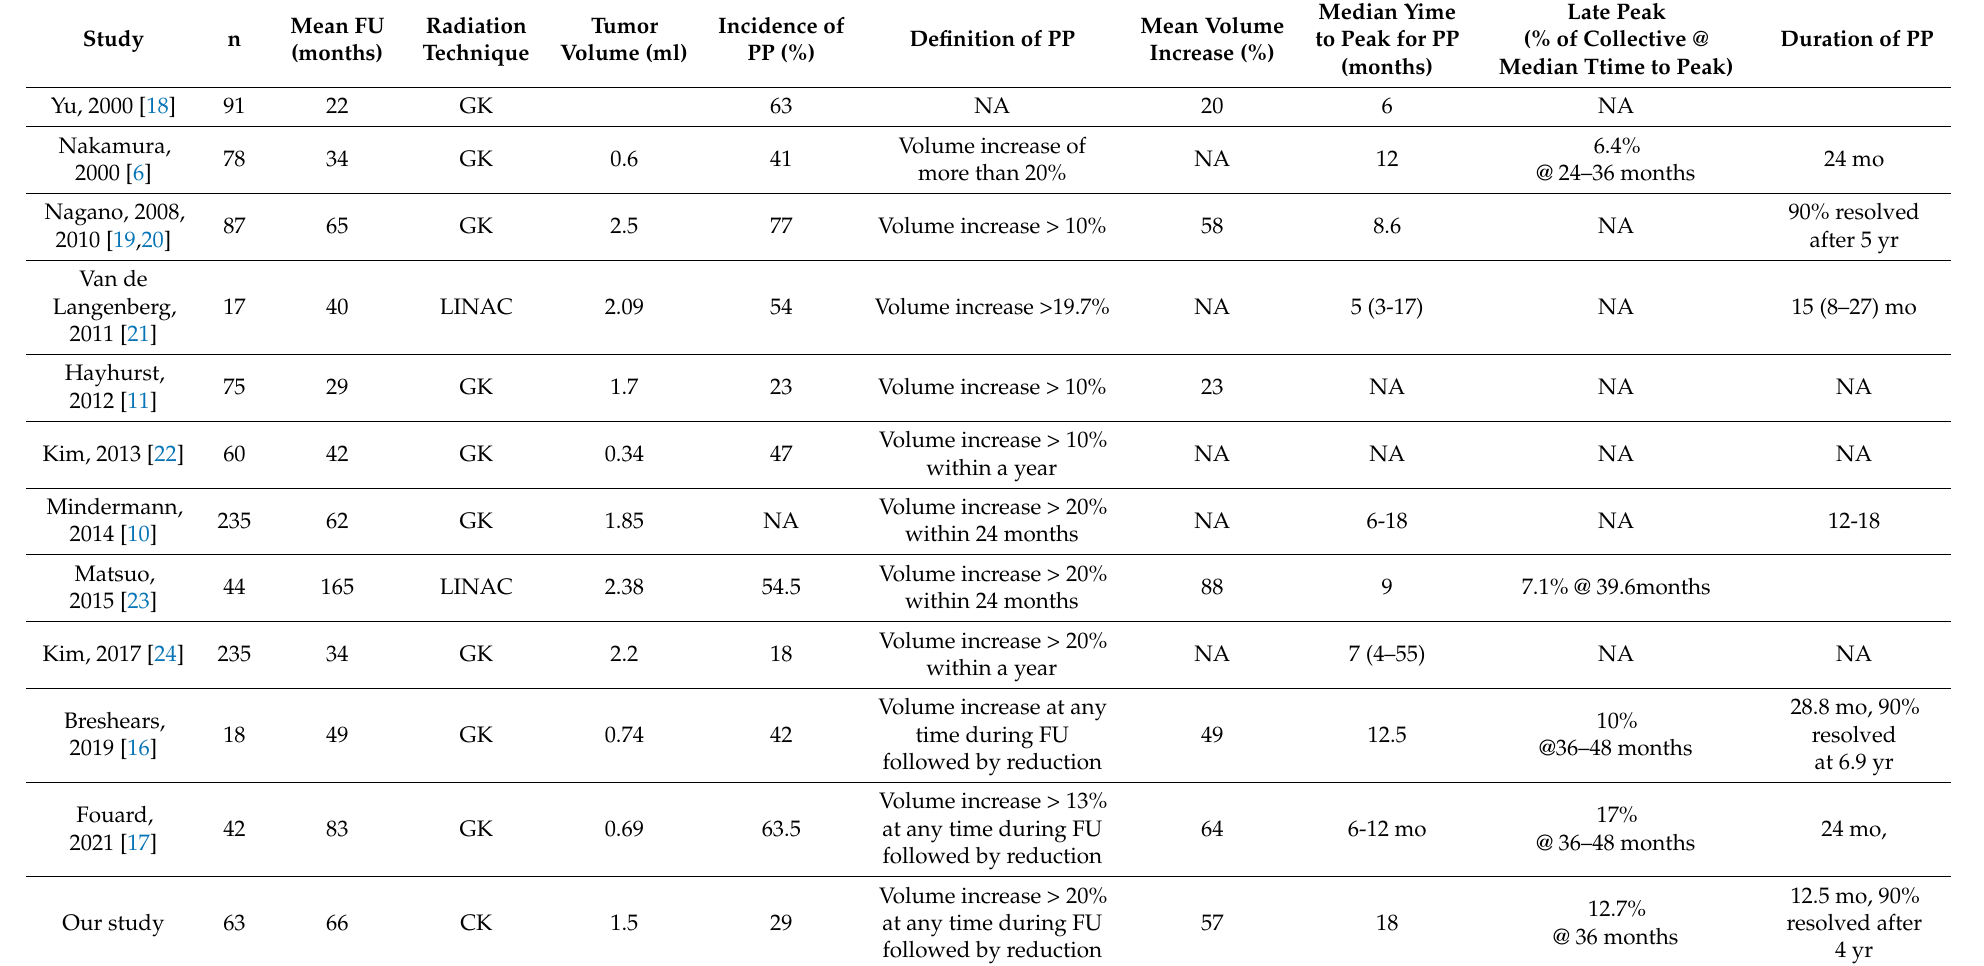
Table 4. Summary of pseudoprogression after single fraction SRS of vs. evaluated by volumetric analysis in former studies. Incidence and time course of